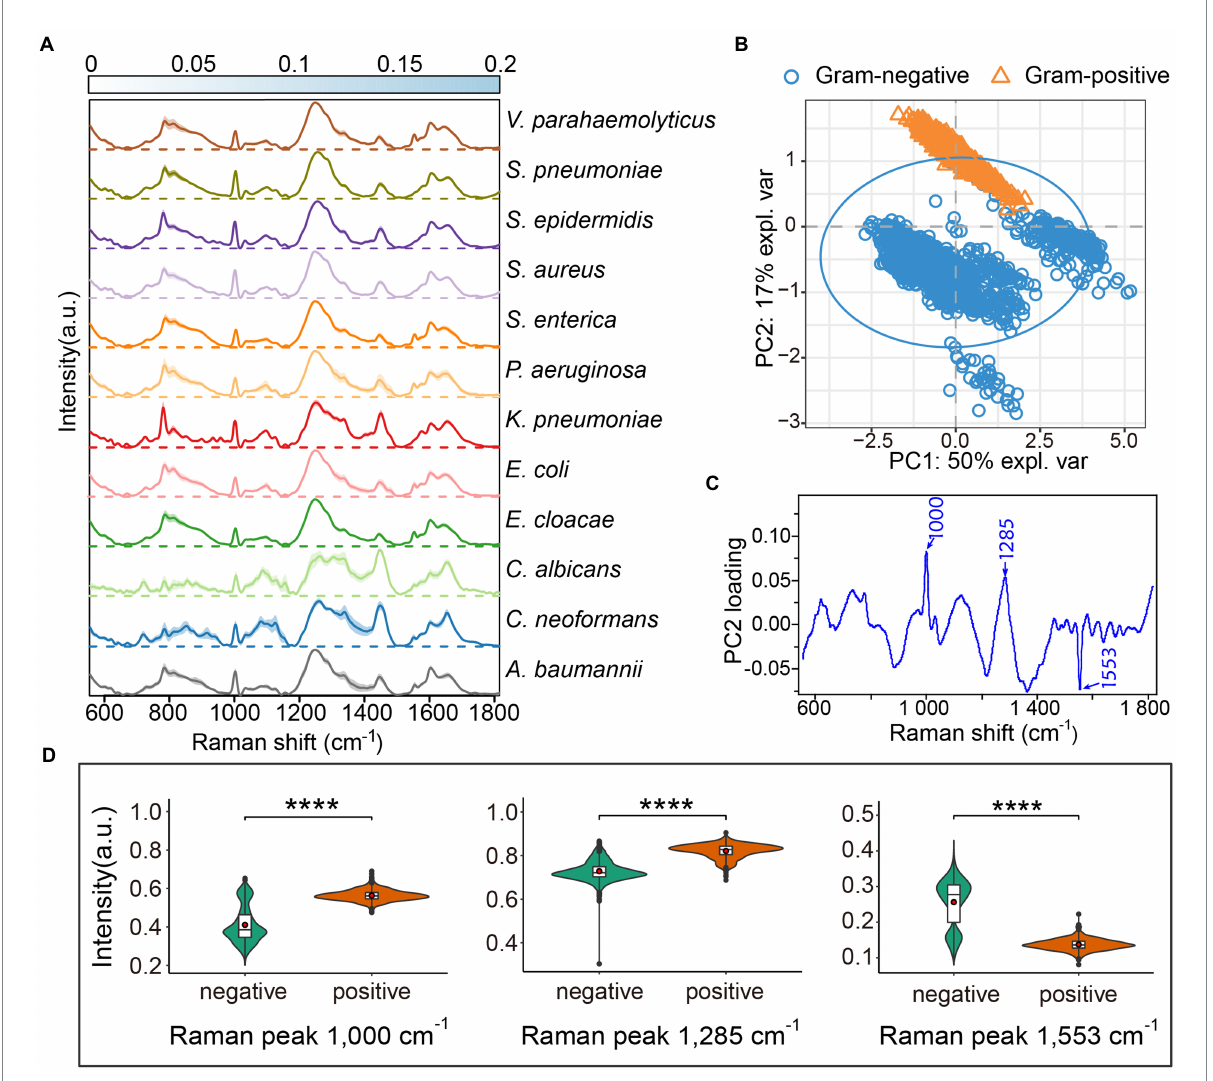
FIGURE 1 Average Raman spectra of 12 common clinical pathogens. (A) The average Raman spectra of each species are shown by the solid line, and the standard deviations are represented by the shadow. The standard deviations for each pathogen are presented by heatmaps to indicate the variations of Raman bands. For each species, the Raman spectra of more than 300 single cells were acquired by LTRS. (B) Principal component analysis (PCA) between gram-positive and gram-negative bacteria. The explained variance (expl. var) of the first two PCs are 50 and 17%, respectively. The confidence ellipse of each strain is 0.95. (C) The loading of PC2 in PCA analysis. (D) Raman intensity of gram-positive and gram- negative bacteria at peaks 1,000, 1,285 and 1,553 cm − 1 , shown by violin plots. Embedded box plots represent the median and first and third quartiles, with the whiskers representing the minimum and maximum values within 1.5 interquartile ranges from the first and third quartiles. Red dots are average Raman intensity. Two sided t -tests were applied to compare the statistical significances between gram-positive and gram- negative bacteria. **** p ≤